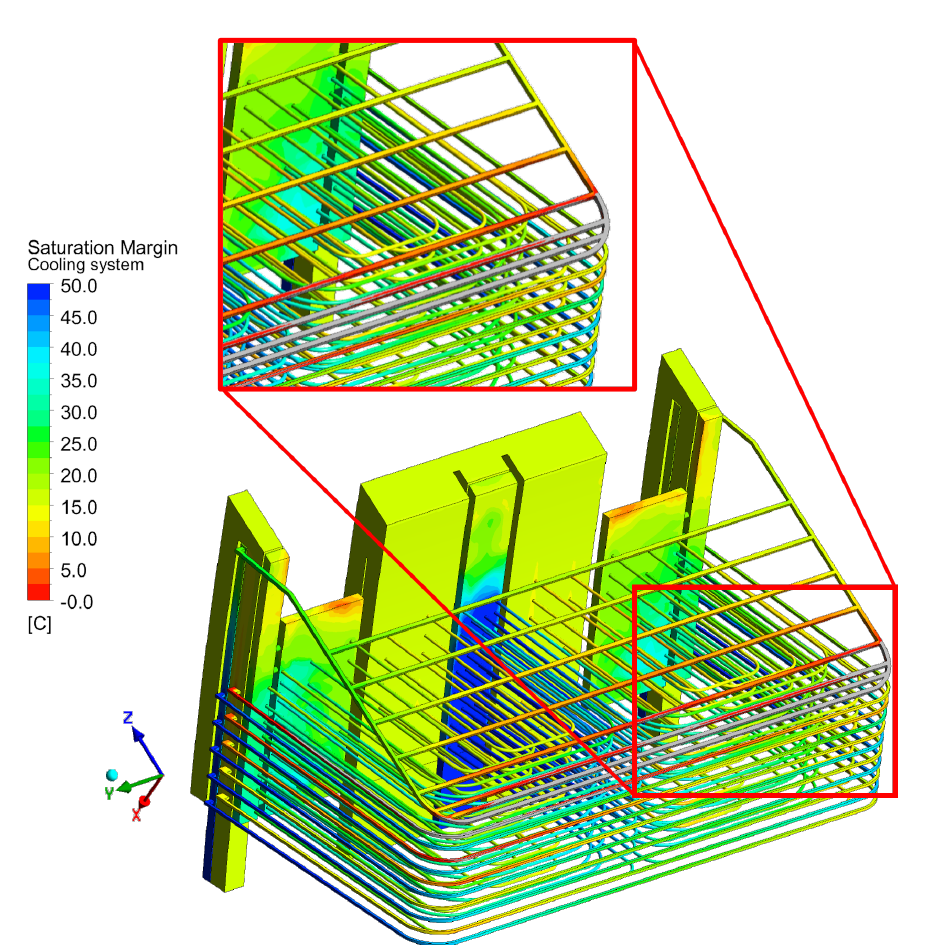
Figure 15. Saturation margin field of the SB cooling